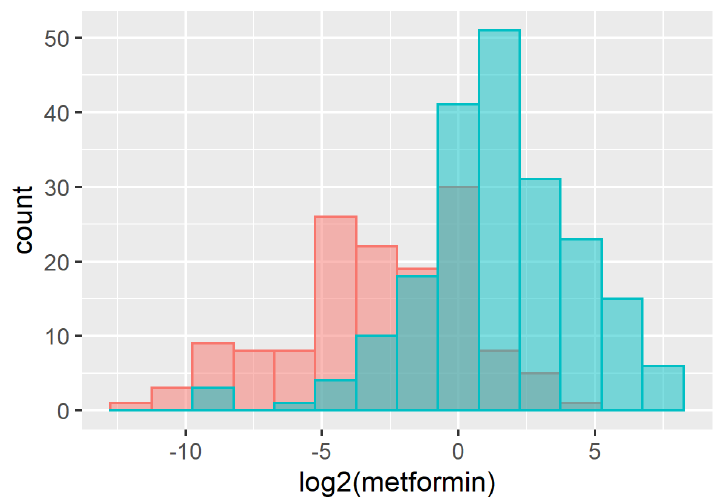
Figure 6. Histogram of metformin counts (batch-corrected, log-scaled, relative units) in individuals who self-reported using metformin (blue) and individuals who were unlikely to use metformin (red); Of 571 individuals who are unlikely to take metformin, 431 (75.5%) have no metformin detected in their blood samples, whereas 140 (24.5%) do; of the 220 individuals who self-report using metformin, 203 (92.3%) have metformin detected in their blood and only 17 (7.7%) do not.